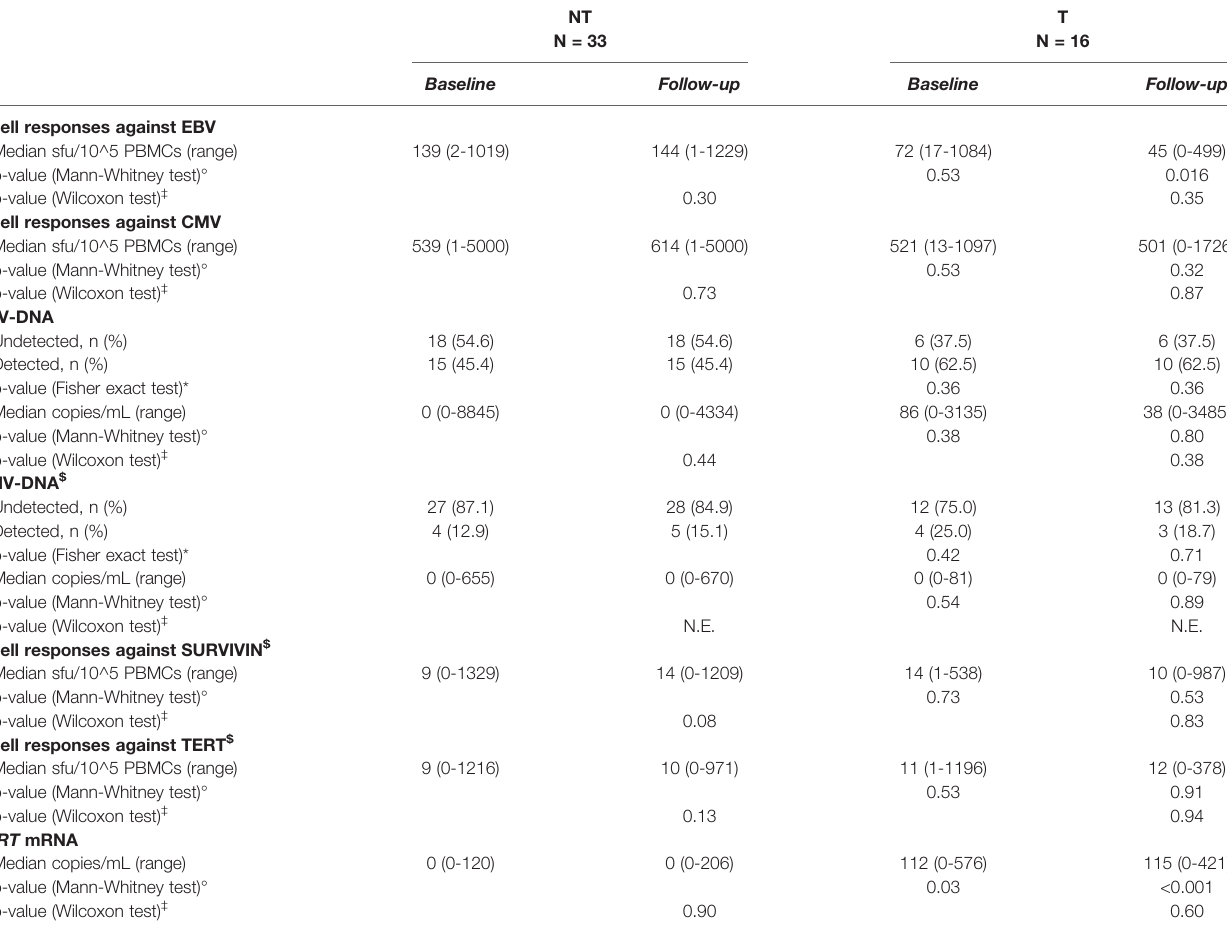
TABLE 2 | Biological parameters in the 49 SOT patients after strati fi cation by tumor occurrence.